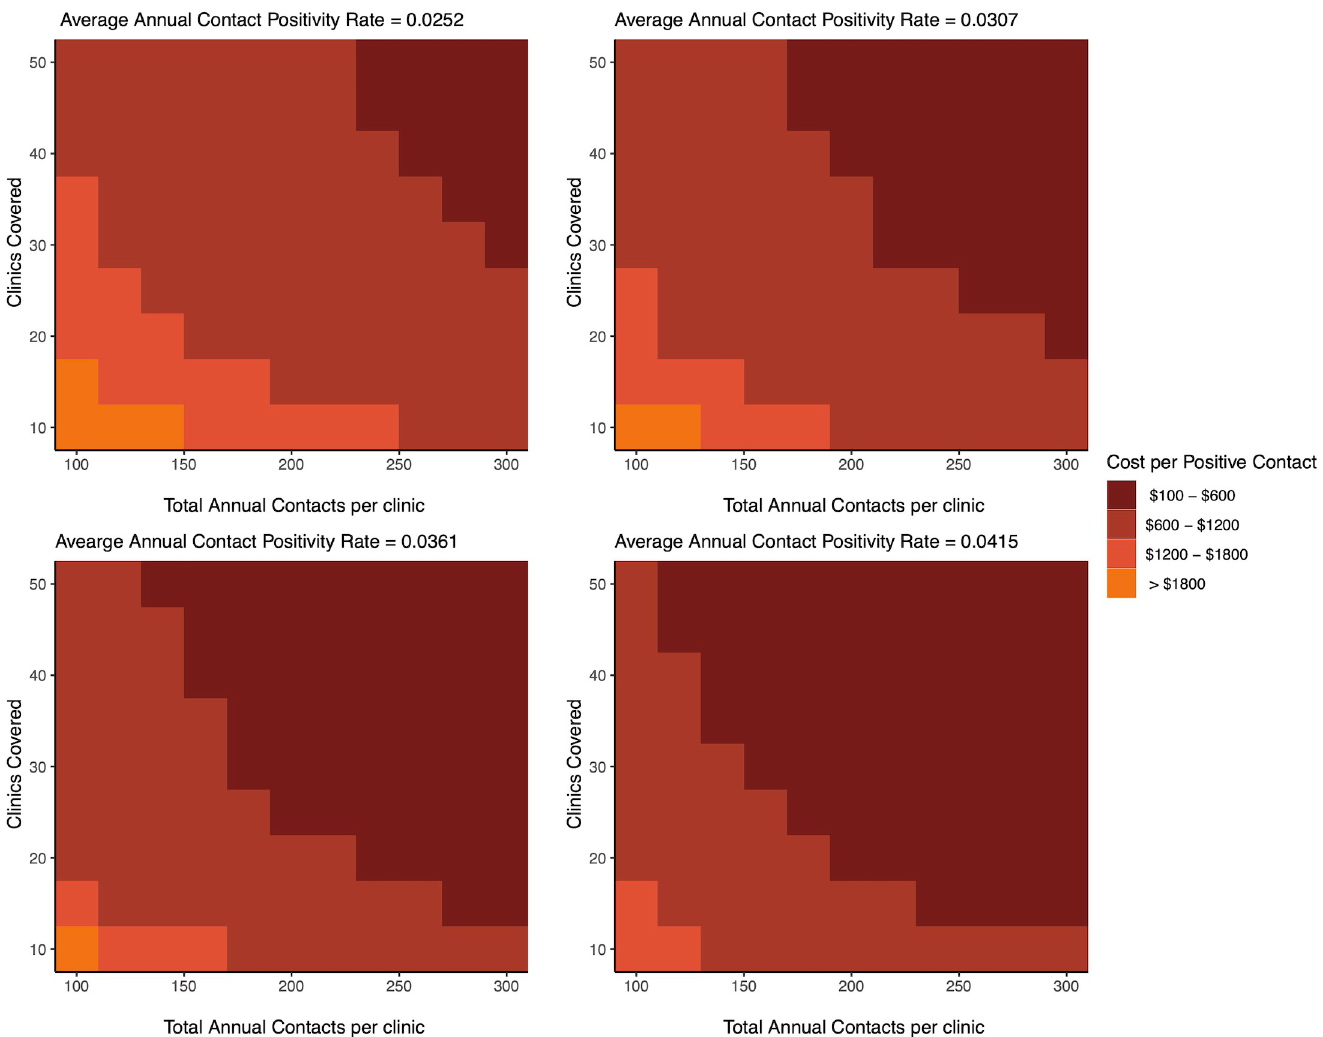
Fig 2. Three-way sensitivity analysis of the cost per TB case detected. Each graph represents the cost of an mHealth-facilitated TB contact investigation program as the average annual contact positivity rate (number of contacts diagnosed with TB divided by the number of contacts evaluated) varies from 0.0252 to 0.0307 to 0.0361 to 0.0415 among household contacts of TB patients. The y-axis represents the number of clinics covered by the program and the x-axis the total annual contacts at each clinic. The orange hue gradient represents the cost gradient associated with different program coverage capacities, with the darkest shade representing scenarios with the lowest programmatic costs and the lightest shade representing scenarios with the highest programmatic costs. Abbreviations: CHW, Community health worker; RCT, randomized-controlled trial; SMS, short-messaging service; TB,